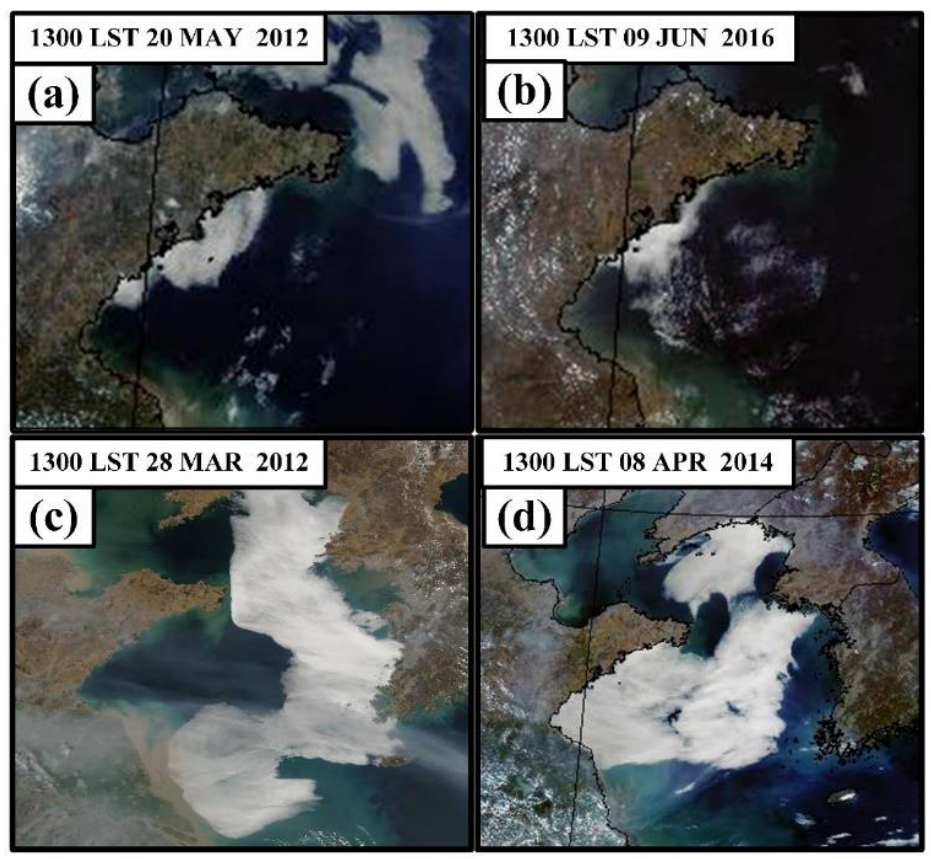
Figure 2. Satellite images of two kinds of typical sea fog episodes over the Yellow Sea: coastal sea fog along the Shandong Peninsula ( a , b ) and widespread sea fog ( c , d